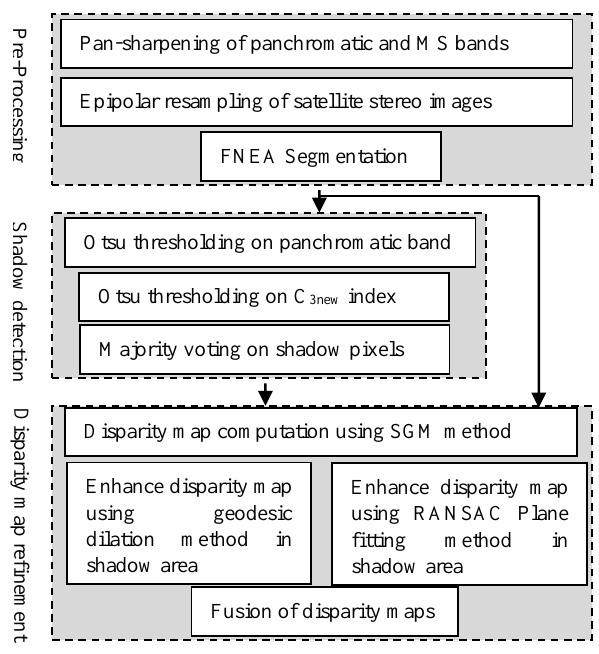
Figure 2. Flowchart of proposed method to enhance the disparity map in SGM